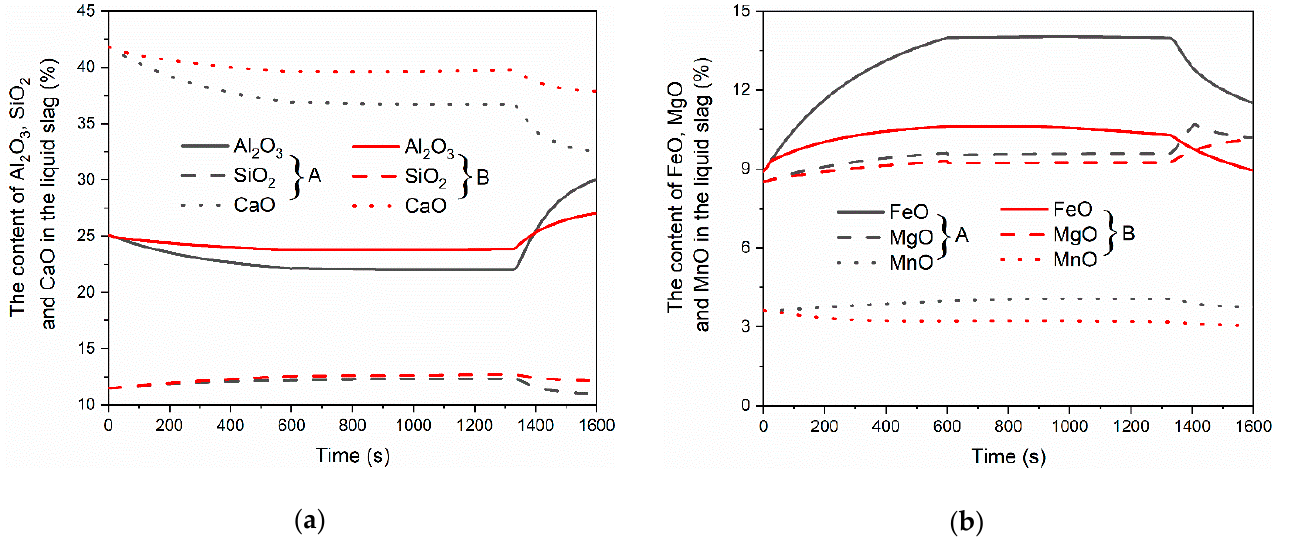
Figure 6. Comparing the slag compositions in the refining process ( a ) Al 2 O 3 , SiO 2, and CaO; ( b ) FeO, MgO, and MnO.